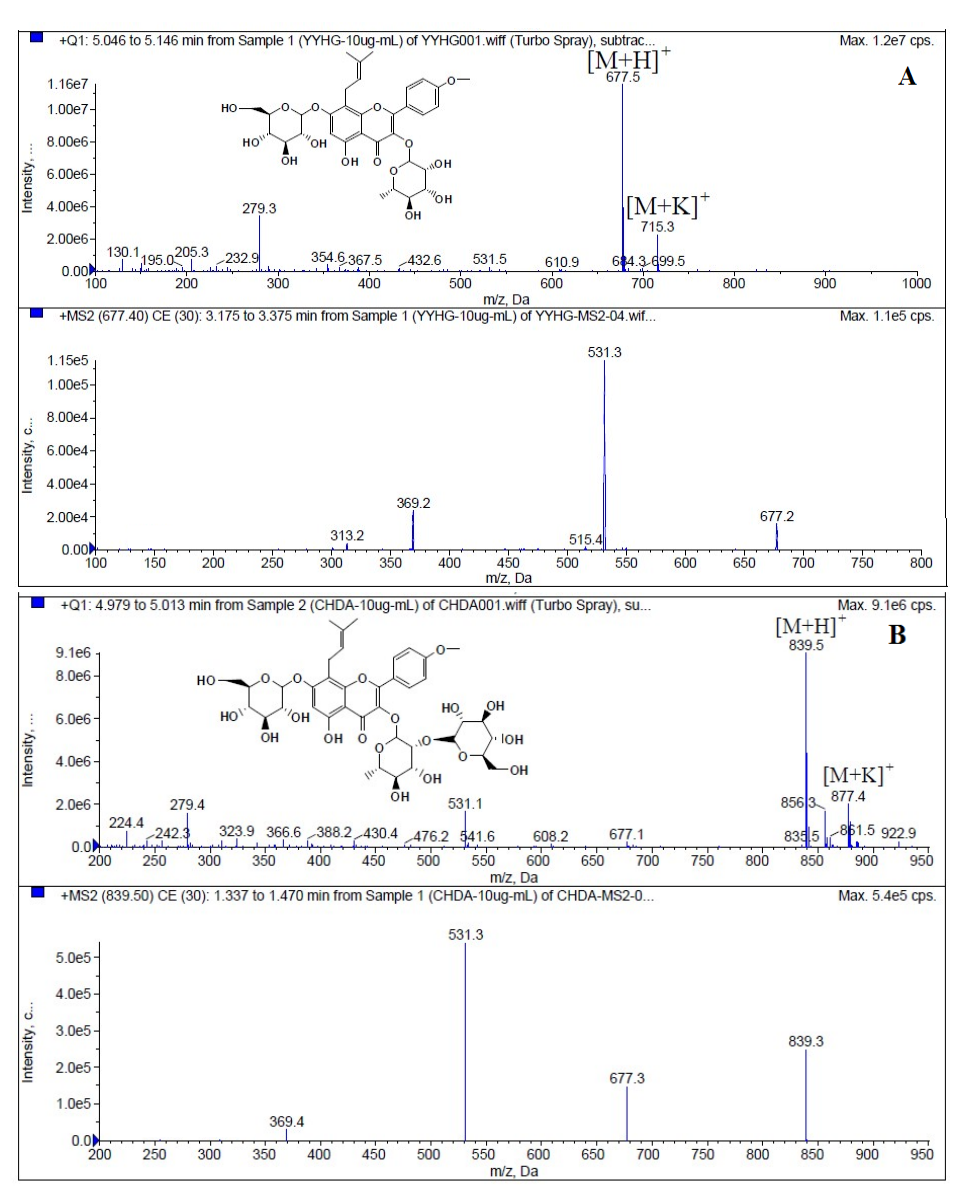
Figure 5. Mass spectra corresponding to prenylflavonoids. ( A ) MS and MS 2 spectrum of icariin; ( B ) MS and MS 2 spectrum of epimedin A; ( C ) MS and MS 2 spectrum of epimedin B; ( D ) MS and MS 2 spectrum of epimedin C; ( E ) MS and MS 2 spectrum of baohuoside